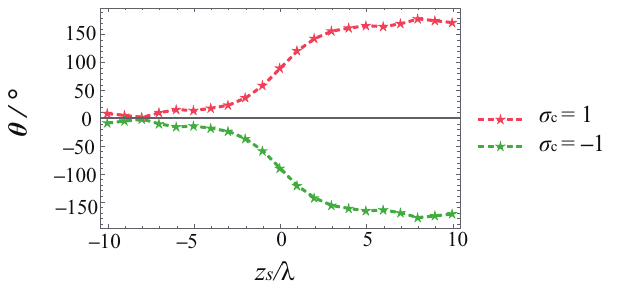
Figure 4. The rotation angle for the transverse energy flux s xy with the beam propagation. Here, a = 0.5 w 0 , f = 2 mm, w 0 = 2 mm and α = 60 ◦ .